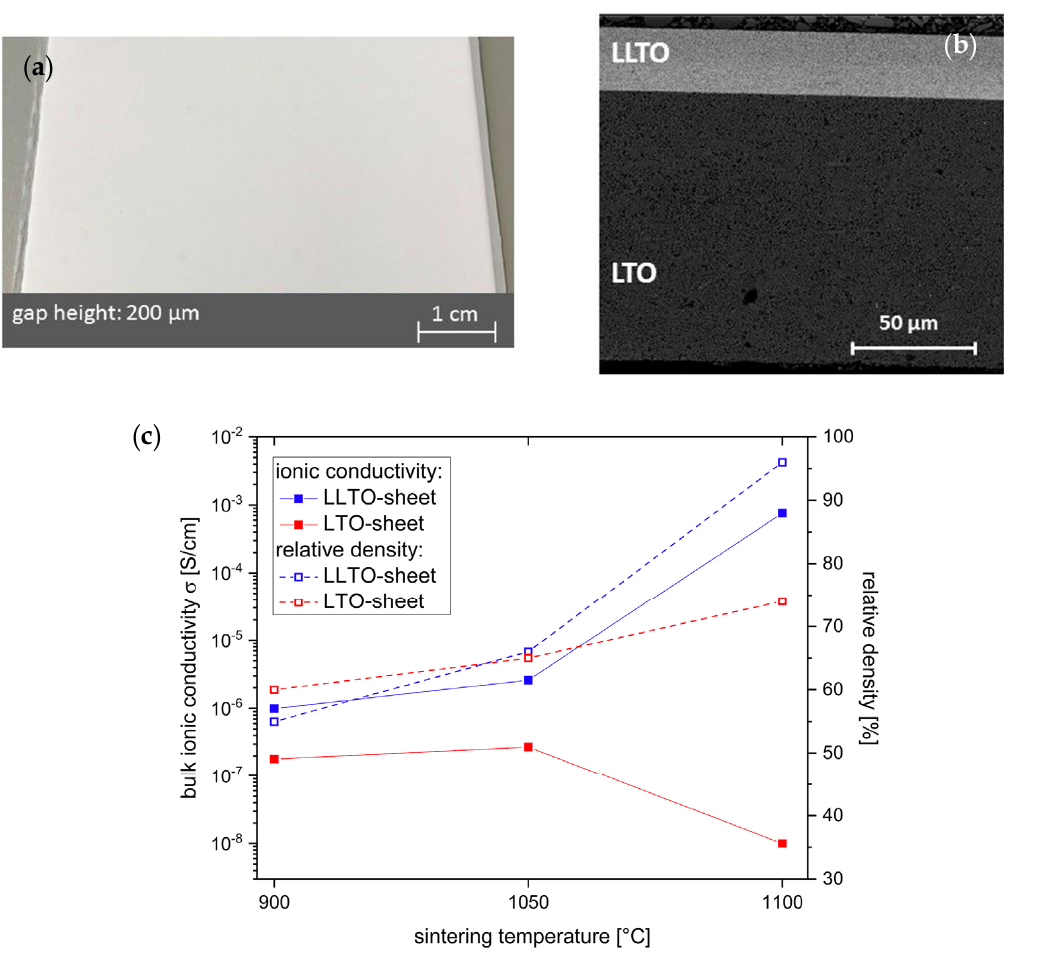
Figure 11. Schematic images of: ( a ) LLTO green tapes; ( b ) microstructure of the cross section and interface between LLTO and electrode sintered at 1100 ◦ C for 1 h; and ( c ) plot of the real resistance for sintered LLTO. Reprinted from [104], Copyright (2019), with permission from Elsevier.